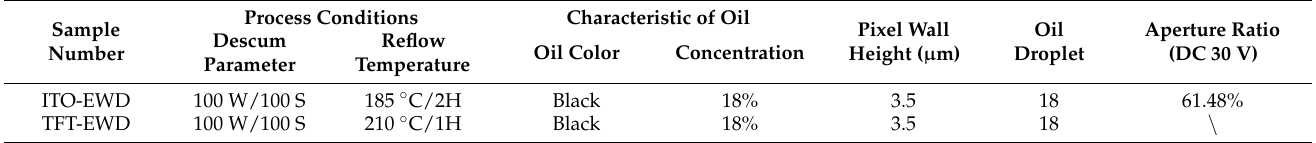
Table 1. The test parameters of the